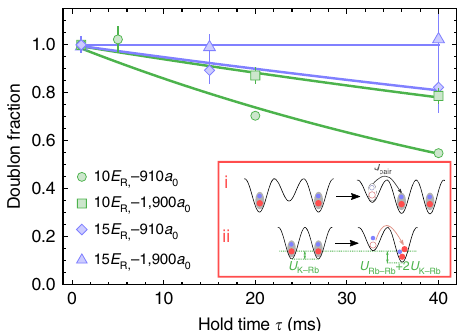
Figure 4 | Longer time dynamics. The dependence of the doublon fraction on the hold time t in the lattice for both 10 E R (green circles and squares) and 15 E R (blue diamonds and triangles) for either a K-Rb ¼ (cid:2) 1,900 a 0 (circles, diamonds) or a K-Rb ¼ (cid:2) 1,900 a 0 (squares, triangles). The lines are fits to an exponential decay and are intended only as guides to the eye. (Inset) The doublon decay can involve tunnelling of doublons through empty sites (i) prior to loss by the Rb tunnelling process illustrated in (ii). All error bars represent 1 (cid:2) s standard